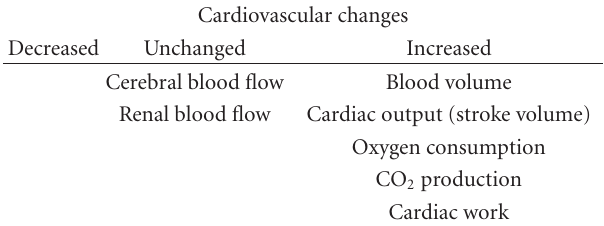
Table 2: Cardiac changes associated with obesity